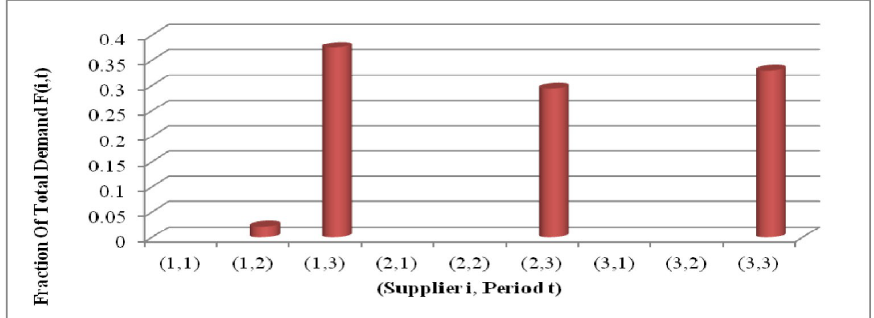
Figure 4. Supply portfolio for α =75%